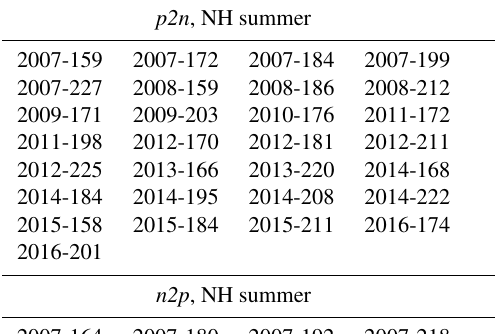
Table 1. Dates (year-day of year) of p2n and n2p IMF B y reversals during 2007 and 2017 in NH and SH